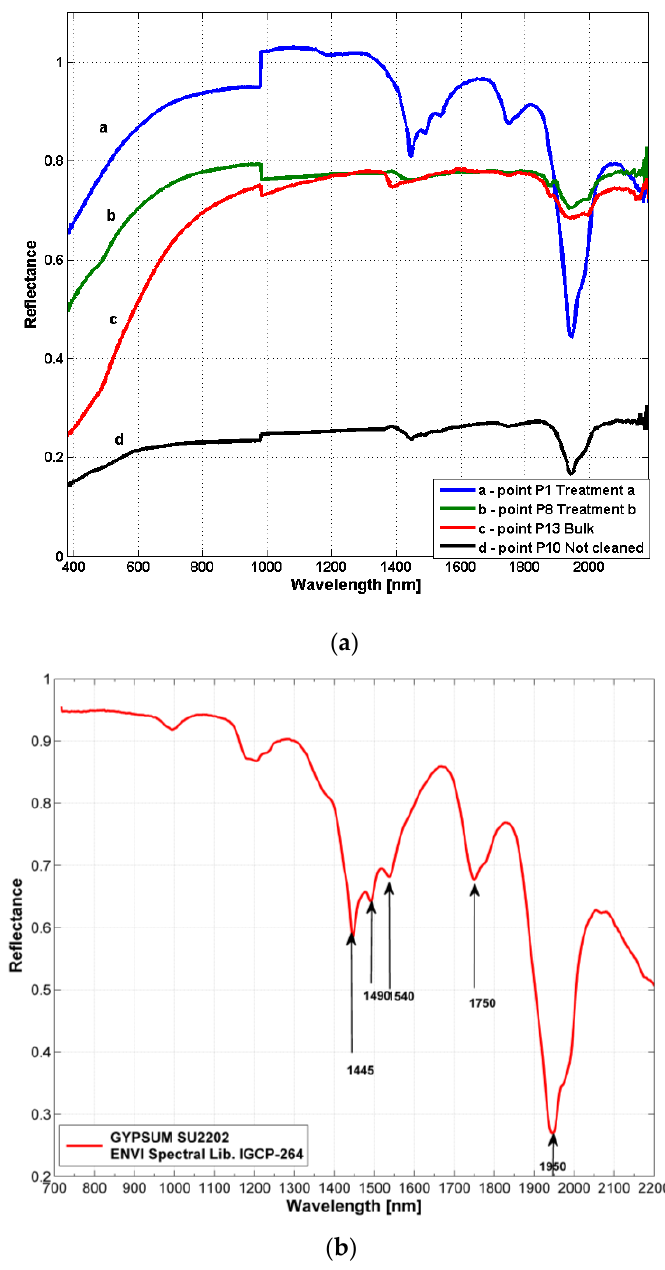
Figure 3. The four types of Vis–NIR reflectance spectra acquired by FORS ( a ), and a reference reflectance spectrum of gypsum (GYPSUM_SU2202 from ENVI Spectral Library IGCP-264 Project CSES Beckman) ( b ).